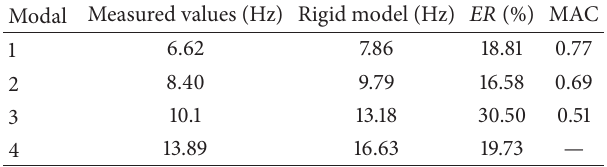
Table 2: Comparison of the actual measured and rigid model